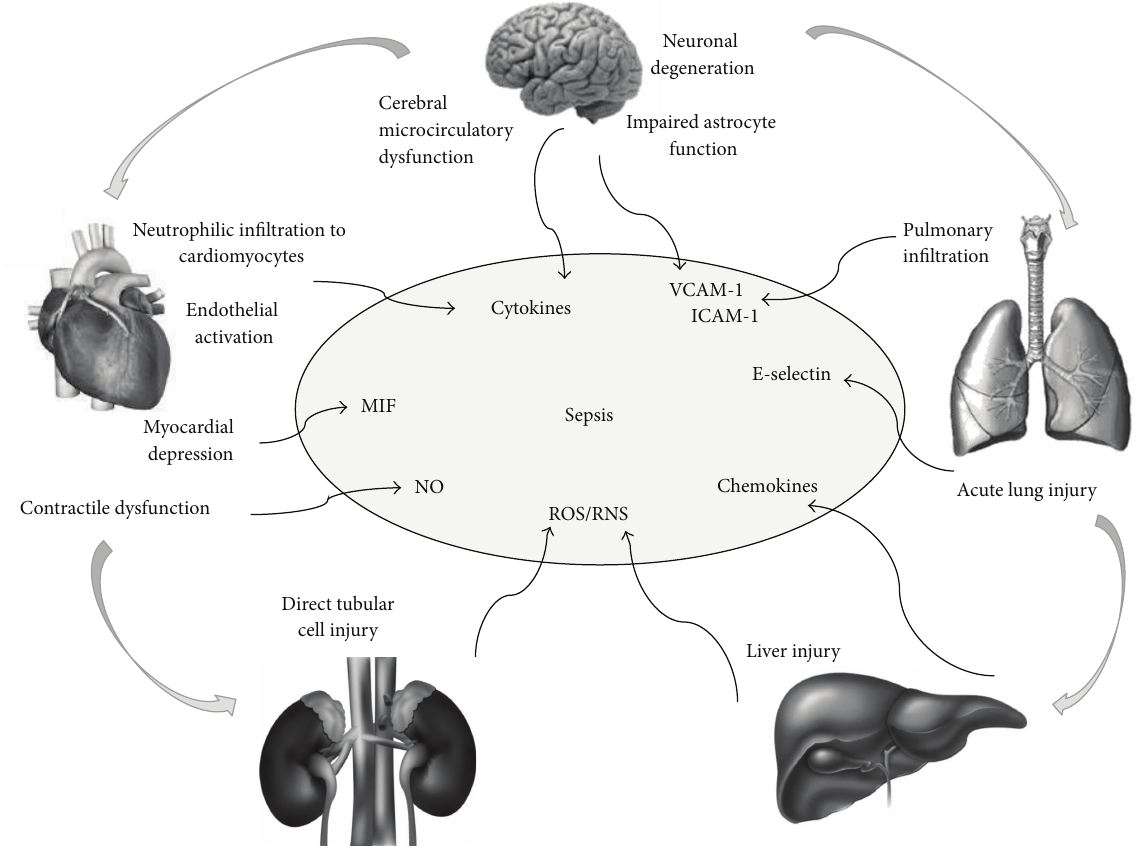
Figure 2: A schematic representing the involvement of different organs in sepsis. During sepsis large amounts of inflammatory mediators are found within the bloodstream. They can act on different organs and induce tissue injury that in turn will favour further production of inflammatory mediators. Cross talk between the different organs and tissues is further mediated by the local delivery of mediators that can amplify or limit the inflammatory response (MIF, macrophage migration inhibitory factor; NO, nitric oxide; ROS, reactive oxygen species; RNS, reactive nitrogen species; VCAM-1, vascular adhesion molecule-1; and ICAM-1, intercellular adhesion